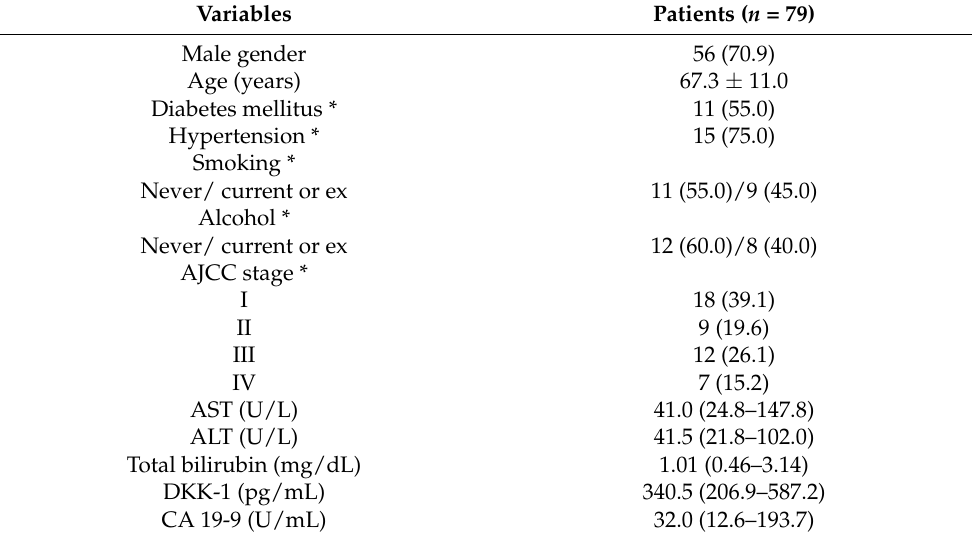
Table 1. Baseline